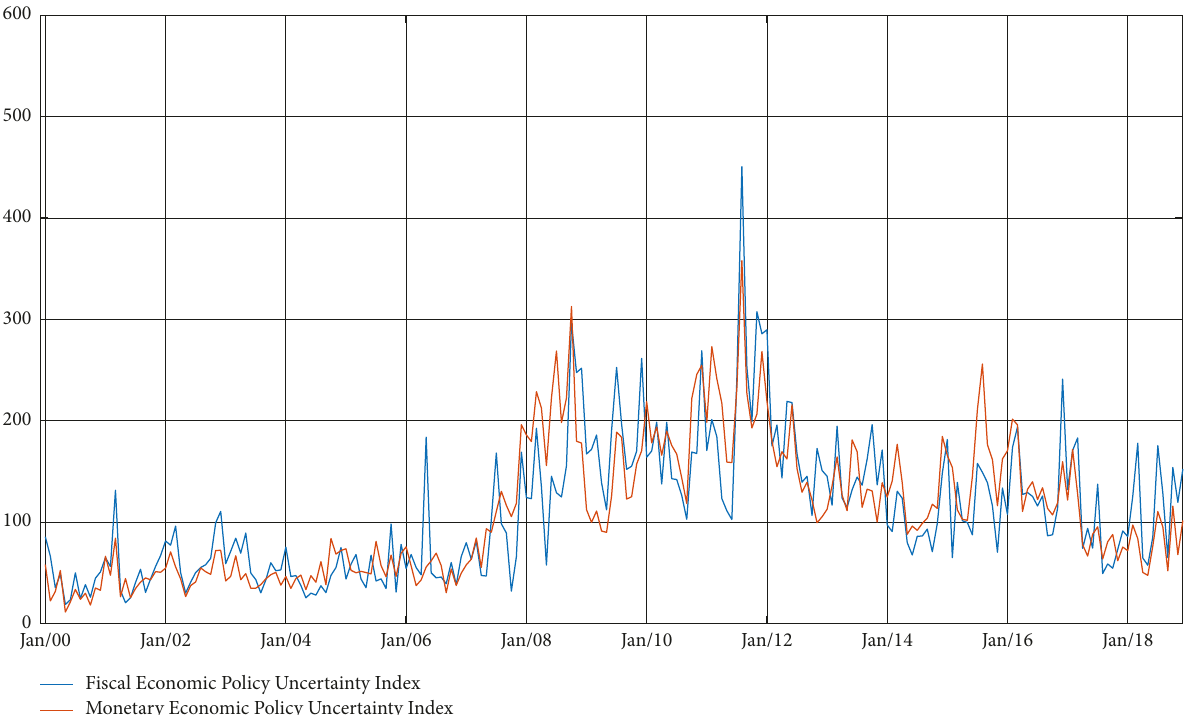
Figure 7: The two other EPU indices: The fiscal EPU index and monetary EPU index. Note: these two EPU indexes are also constructed by Huang and Luk